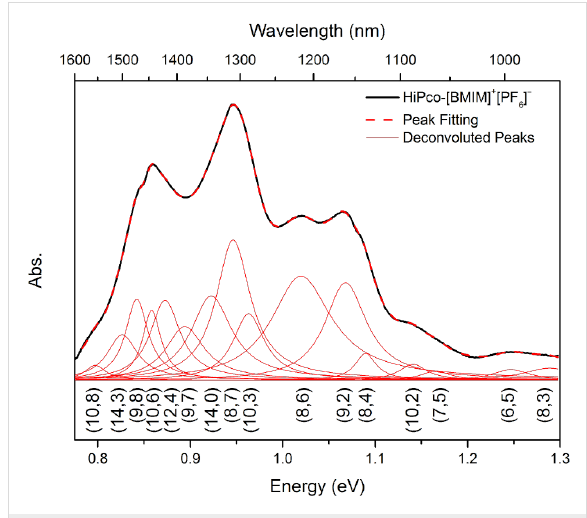
Figure 5: Deconvolution of the baseline-corrected absorption spectra of [BMIM] + [PF 6 ] − -dispersed SWNTs in the semiconducting nanotube E 11 region with the solid black curve denoting the baseline-corrected spectrum, the dashed red curve denoting the fitting spectrum, and the solid red curves denoting the deconvoluted individual peaks corres- ponding to different chiralities of the semiconducting nanotubes.